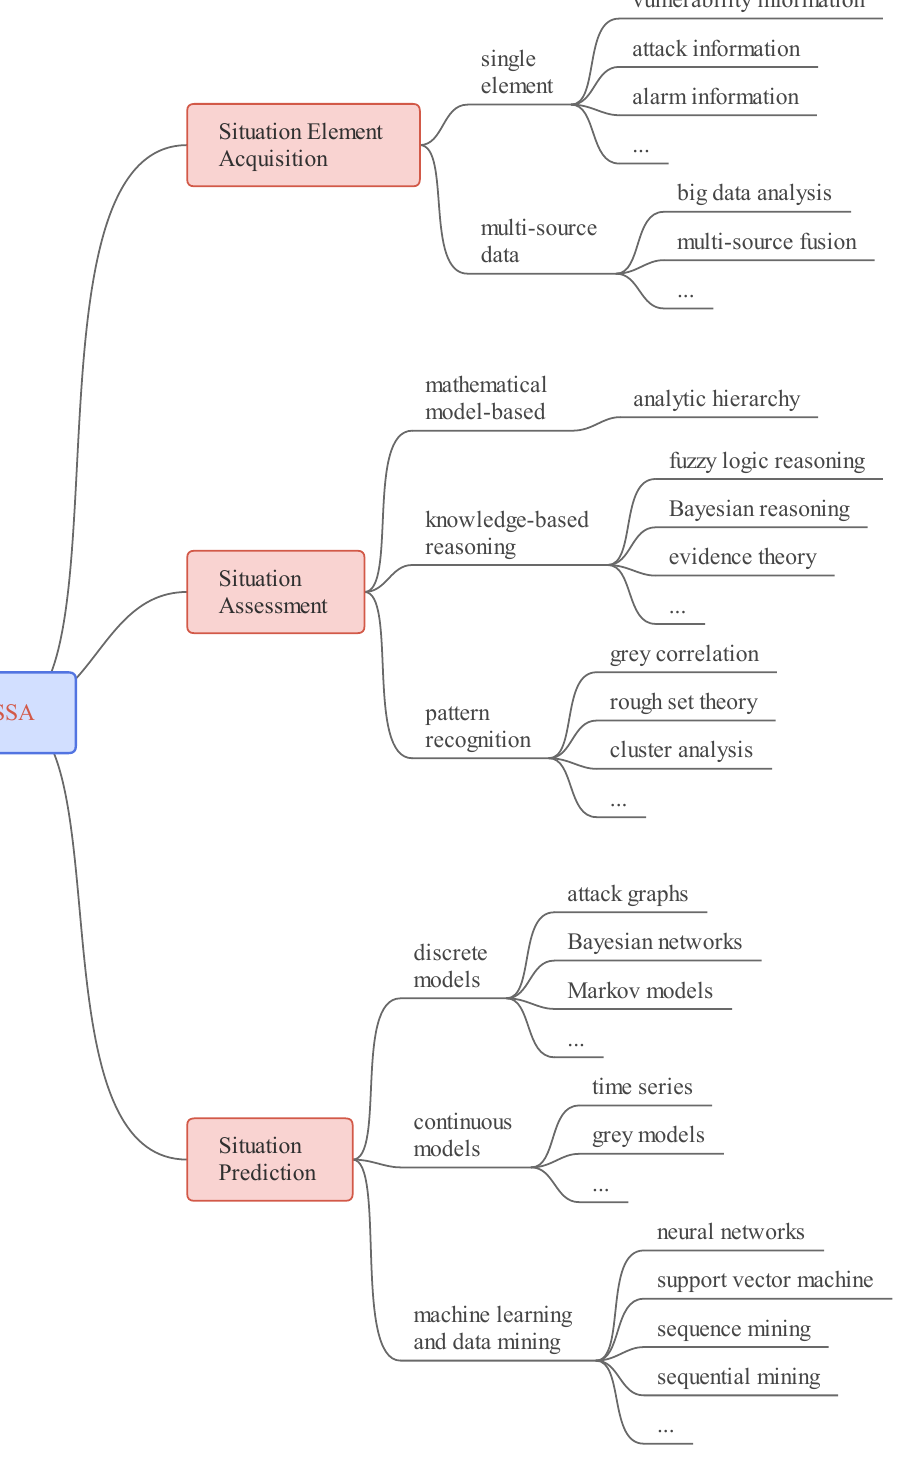
Figure 6. The key technologies of